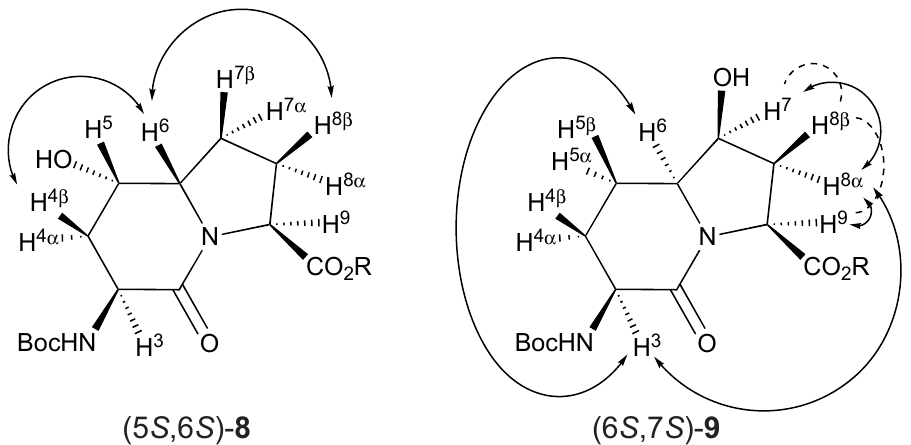
Figure 2. Strong (solid double-tipped arrows) and weak (dotted lines) through-space transfer of magnetization used to assign relative stereochemistry of (5 S ,6 S )- 8 and (6 S ,7 S )- 9 . The ring fusion protons (3.88 and 3.74 ppm) of 5- and 7-hydroxy Boc-I 2 aa-OMe (5 S ,6 S )- 8 and (6 S ,7 S )- 9 were respectively assigned the S stereochemistry based on nuclear Overhauser effects (nOe) with the C4 β and C8 β protons (1.99 and 1.84 ppm) and with the C3 proton (4.13 ppm, Figure 2). No long-range through-space transfer of magnetization